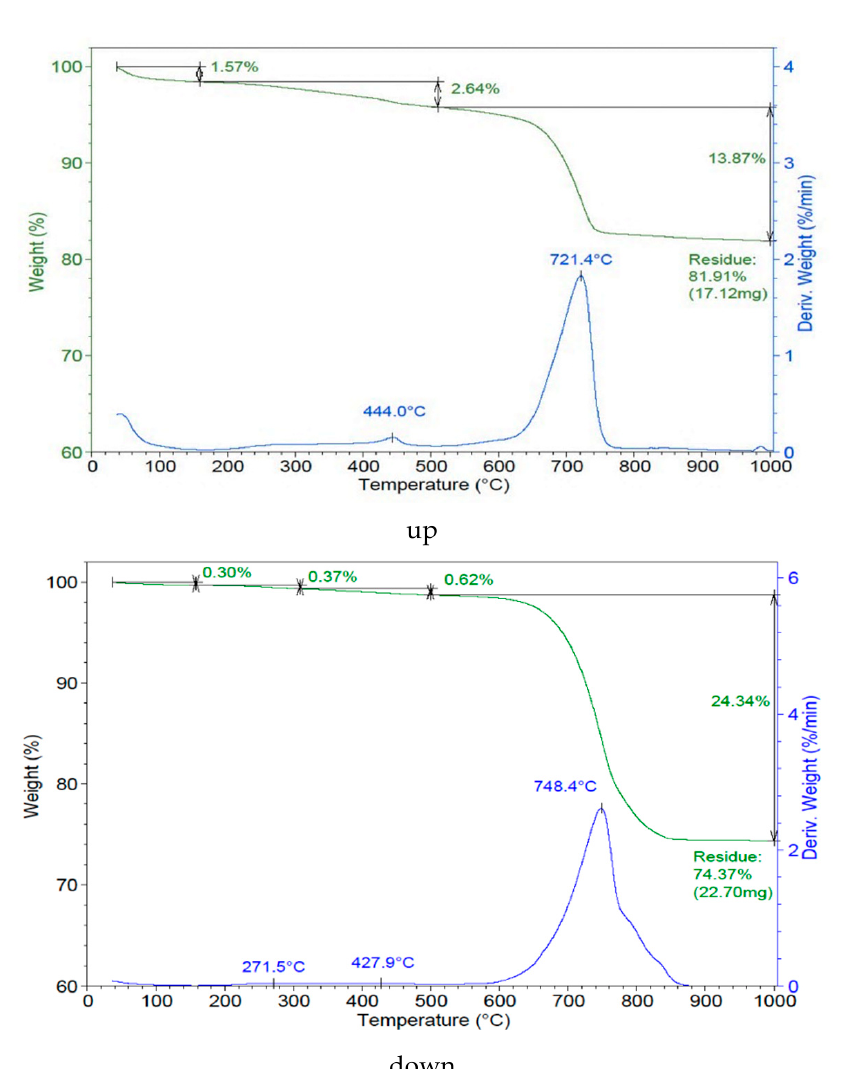
Figure 9. Thermal analysis for the blue ( up ) and green ( down ) pigments zone.